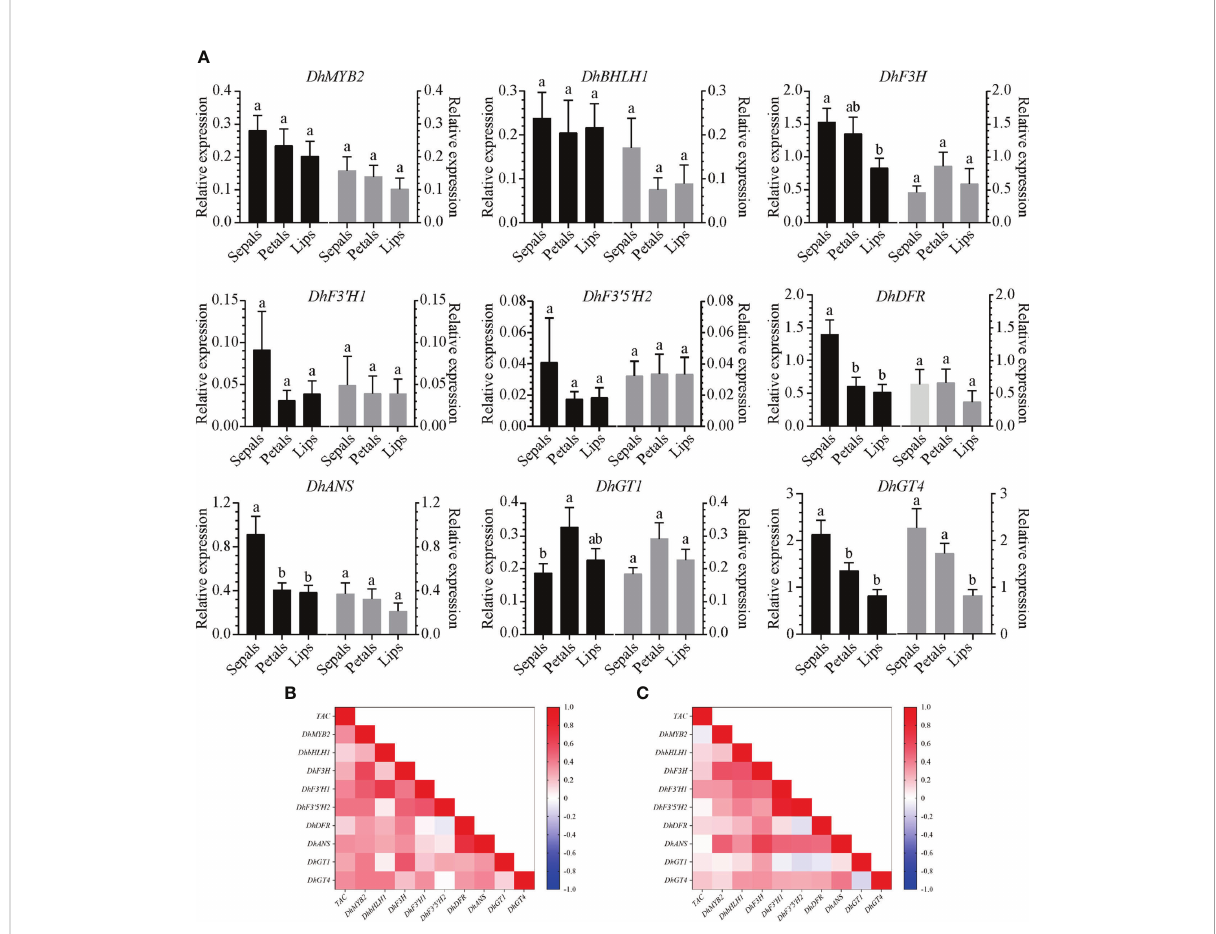
FIGURE 5 Correlation analyses between the expression of anthocyanin biosynthesis related genes and anthocyanin content in different fl oral tissues of two Dendrobium hybrid families. (A) . Expression pro fi les of anthocyanin biosynthesis related genes in sepals, petals and lips of Dendrobium hybrid progenies. The black columns represent “ BP ” hybrid progenies while the gray columns represent “ ED ” hybrid progenies. Values are expressed as mean -dCt (Ct reference - Ct target) ± SEM using actin as an internal control for normalization. Twenty F1 progenies of each hybrid family were sampled. Different letters indicate signi fi cant differences ( p < 0.05, Duncan ’ s multiple range tests). Comprehensive correlation matrix analyses between anthocyanin biosynthesis related genes and total anthocyanin content (TAC) in combined sepals, petals and lips of F1 progenies from “ ED ” (B) and “ BP ” (C)